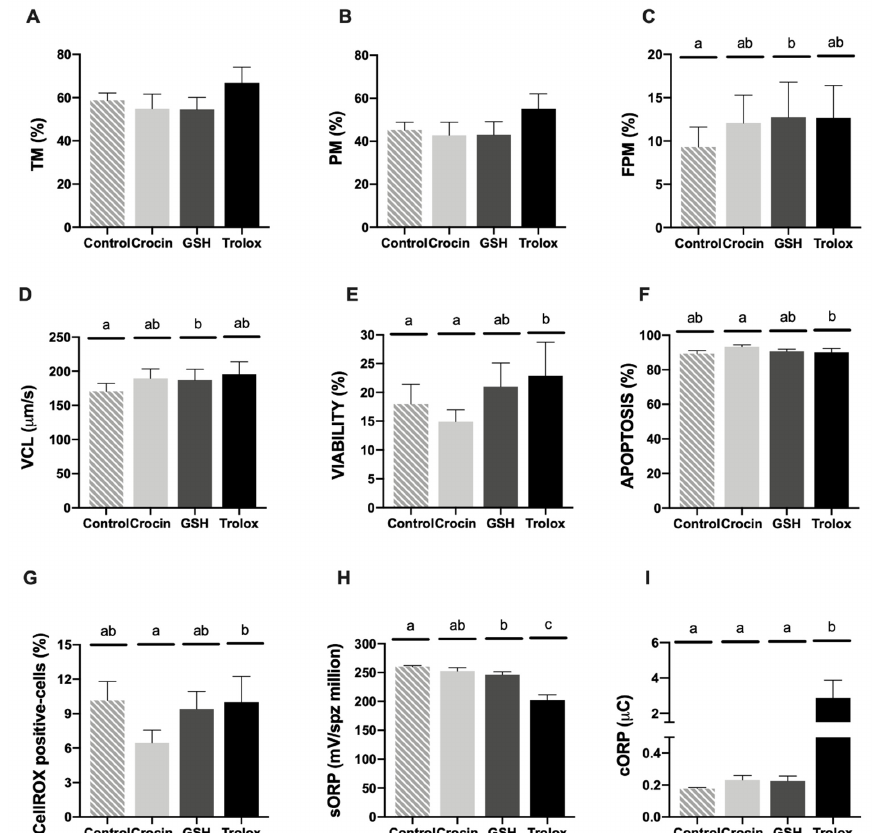
Figure 2. Ram cryopreserved sperm motility and multiparametric flow cytometry analyses in the four experimental groups (control: without antioxidants, 1 mM GSH, 1 mM crocin and 1 mM trolox supplementation). ( A ) Total motility (TM, %); ( B ) progressive motility (PM, %); ( C ) fast progressive motility (FPM, %); ( D ) curvilinear velocity (um/s); ( E ) Zombie negative cells (viability, %); ( F ) caspase 3/7 positive cells (apoptosis, %); ( G ) CellROX-positive cells (sperm ROS levels, %); ( H ) static ORP (sORP) index (mV/10 6 sperm); ( I ) capacitance ORP (cORP) index (µC/10 6 sperm). Results are expressed as the mean ± S.E.M. A total of eight males were analyzed in each experimental group. Significant differences ( p < 0.05) are represented with different lowercase letters.